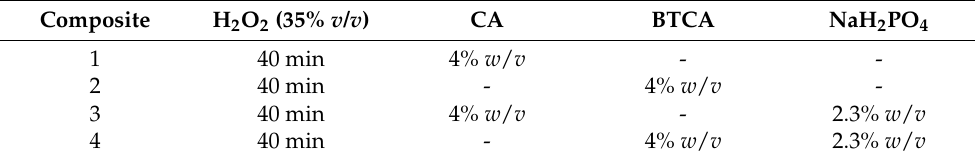
Table 1. Composites’